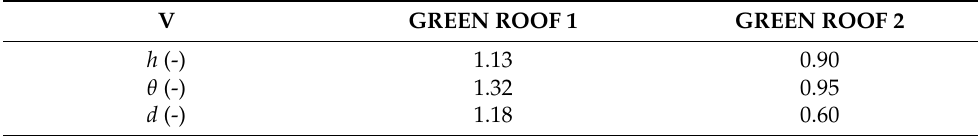
Table 7. Coefficient of variation of rainfall variable in summer.